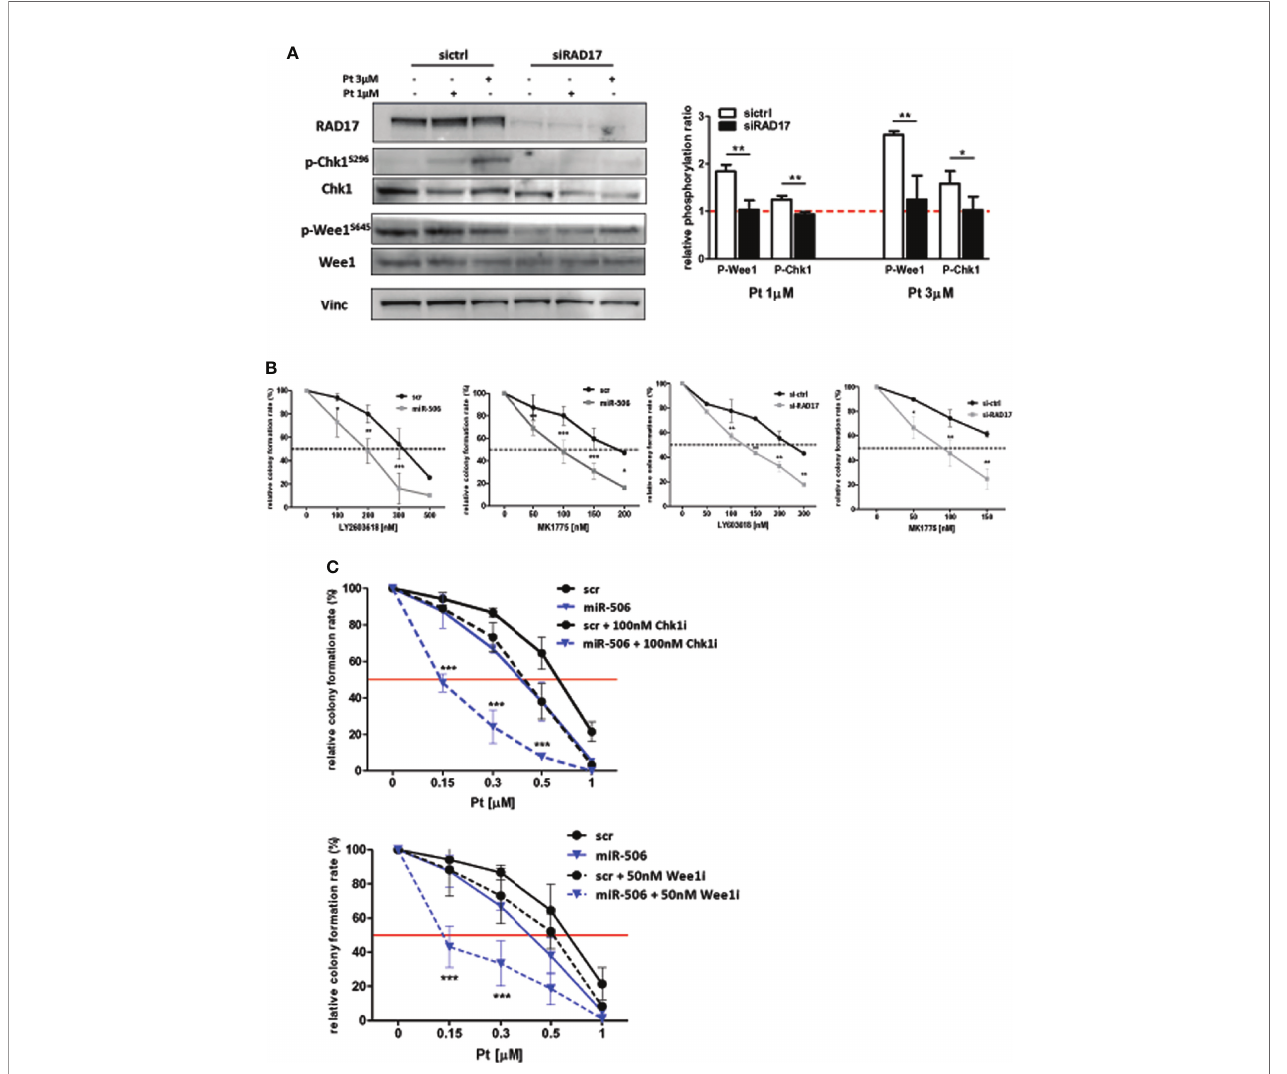
FIGURE 7 | miR-506-3p dependent regulatory axis is synthetically lethal with cell-cycle checkpoint inhibitors. (A) Abrogation of G2/M cell cycle checkpoint activation in RAD17 silenced SKOV3 cells. Western blot analysis on total cell lysates from SKOV3 cells silenced for RAD17 (siRAD17) or with scrambled (sictrl) siRNA and treated or not with 1 and 3 µM Pt. Immunoblottings were performed with Abs against the proteins indicated. Vinculin was used as loading control. Representative western blot images (left panel) and quanti fi cation (right panel) of relative phosphorylation levels calculated as the ratio between phosphorylated and total protein normalized on loading control. Bars in the graph represent the phosphorylation ratio between Pt-treated and untreated cells. Comparison assessed by Student ’ s t test (* p<0.05; ** p<0.01). (B) Forced expression of miR-506-3p or RAD17 silencing induces sensitivity to Chk1 and Wee1 inhibitors in SKOV3 cells. SKOV3 cells were transfected with miR-506-3p mimic or control scrambled miR (miR-506 and scr, left panels), or silenced with siRNA against RAD17 or with a control siRNA (siRAD17 and sictrl, right panels) and tested by clonogenic assays for sensitivity to Chk1 inhibitor (LY603618) or Wee1 inhibitors (MK1775) at the indicated doses. (C) Wee1 or Chk1 inhibition in miR-506-3p reconstituted cells enhanced effect of Pt treatment. Both scr (black lines) and miR-506 (blue lines) SKOV3 cells were treated with Pt at the indicated doses, alone (solid line) or in combination with 100 nM Chk1 inhibitor (Chk1i; LY2603618, dotted lines, upper panel) or 50 nM Wee1 inhibitor (Wee1i; MK1775, dotted lines, lower panel). For each panel, percentages of relative colony formation rate are reported. To compare miR-506 or siRAD17 cells versus their relative control cells ( panel B ) or to compare miR-506 cells treated with Pt alone versus combinations with cell cycle checkpoint inhibitors (panel C), two way ANOVA and Bonferroni ’ s post test was used (*p<0.05; **